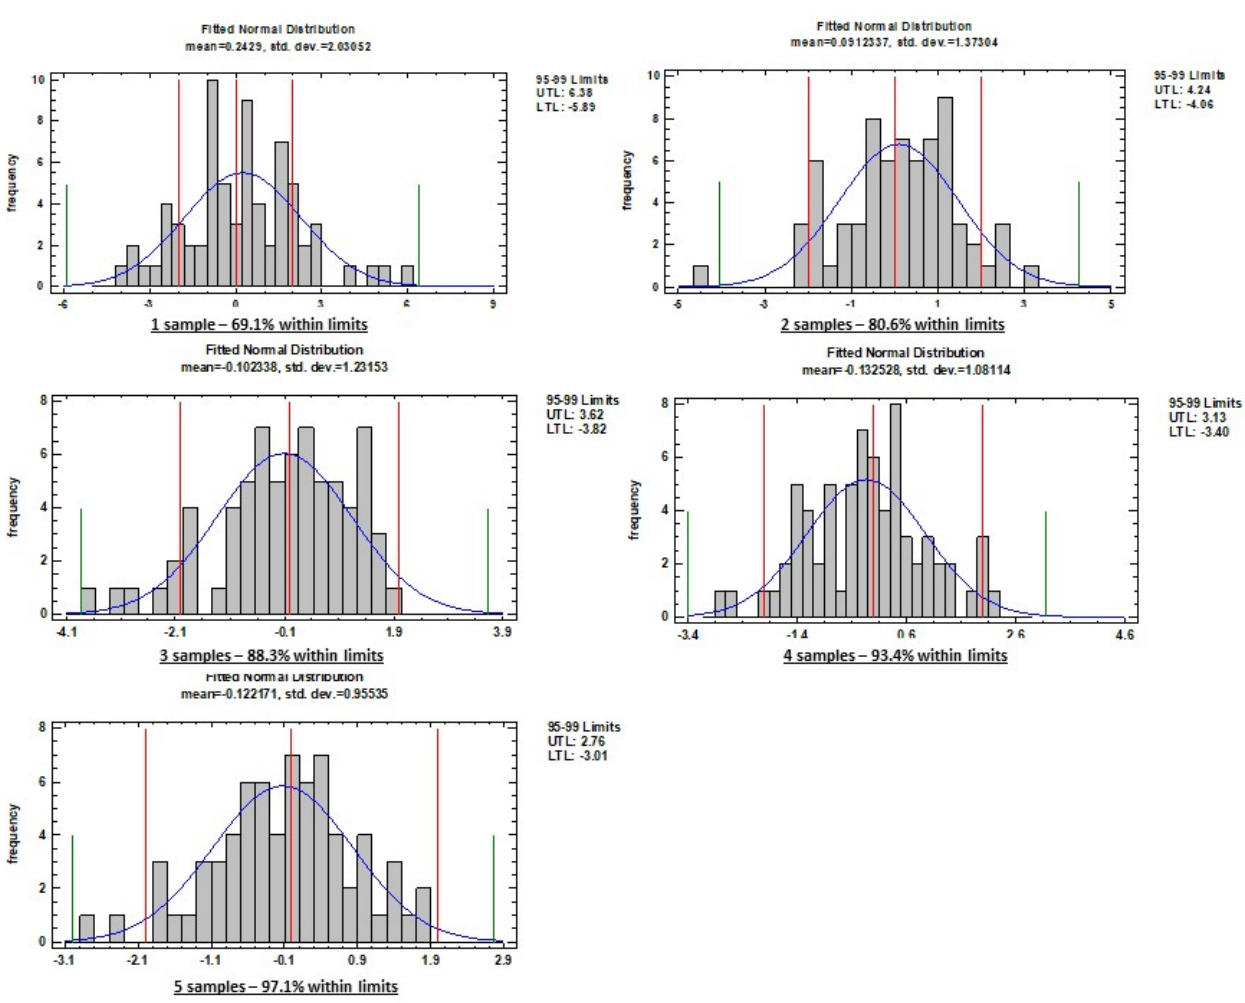
Figure 8. Tolerance plots of the fitted normal distribution representing the frequency of δ values (deviation of MC estimate). The central red line indicates the center of the normal distribution (exact matching). Outer red lines indicate the threshold admitted of ± 2 MC percentage points of error. The percentage of values within the limits is reported below each plot. Table 3. Percentage of δ values below the threshold of ± 2 percentage points of error for the different levels of sampling